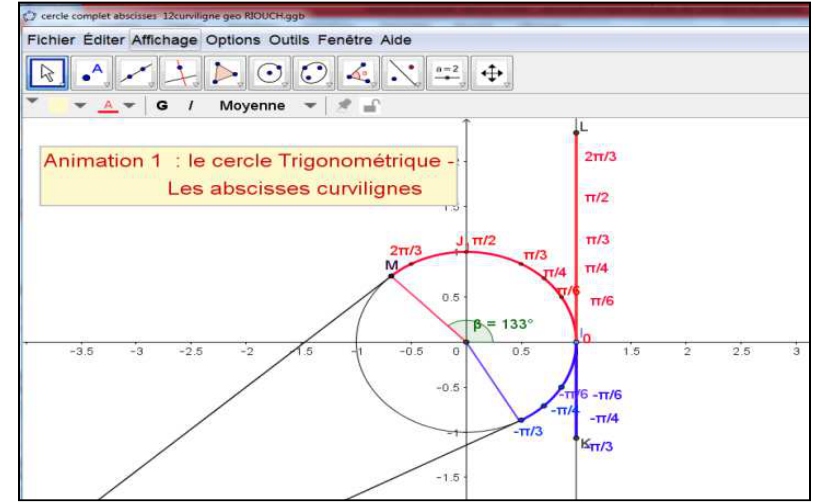
Fig. 4. Présentation avec GeoGebra du cercle trigonométrique (abscisses